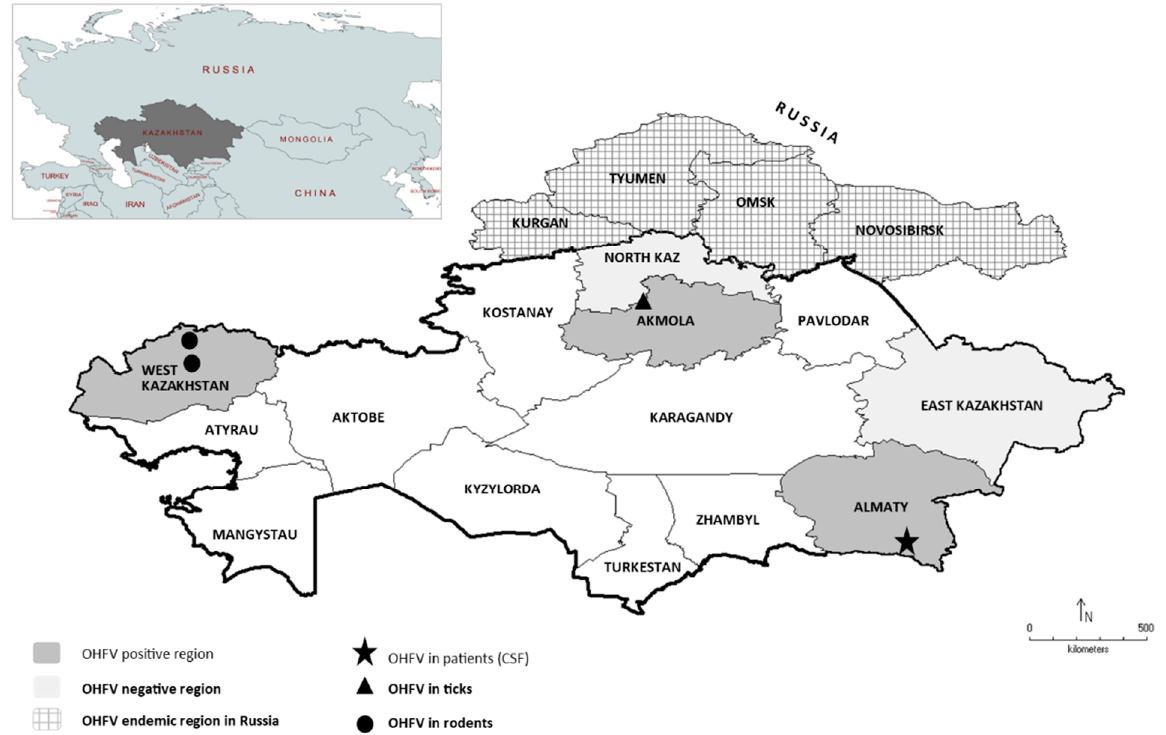
Figure 1. Investigation of Omsk haemorrhagic fever virus (OHFV) in Kazakhstan. Patients with suspected meningitis or meningoencephalitis in East Kazakhstan, Akmola and Almaty city, rodents from Almaty city, Almaty region and West Kazakhstan and ticks originating from North Kazakhstan, Akmola region, Almaty city and Almaty region were screened for OHFV RNA (light and dark grey). OHFV regions identified in this study (dark grey) with OHFV-RNA-positive patients ( ), ticks ( ) and rodents ( ). In North Kazakhstan and East Kazakhstan, no OHFV was identified (light grey). Thus far, OHFV-endemic regions in Russia adjacent to Kazakhstan are Kurgan, Tyumen, Omsk and Novosibirsk (grey pattern).